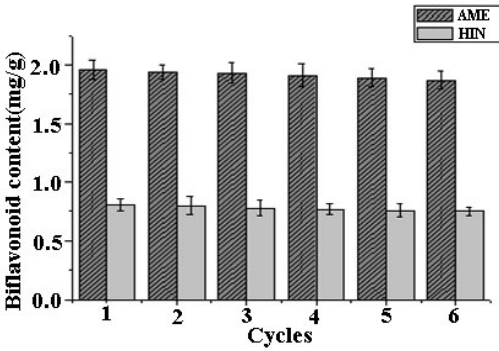
Figure 7. Performance of recovered [C 6 mim]BF 4 on the yields of AME and